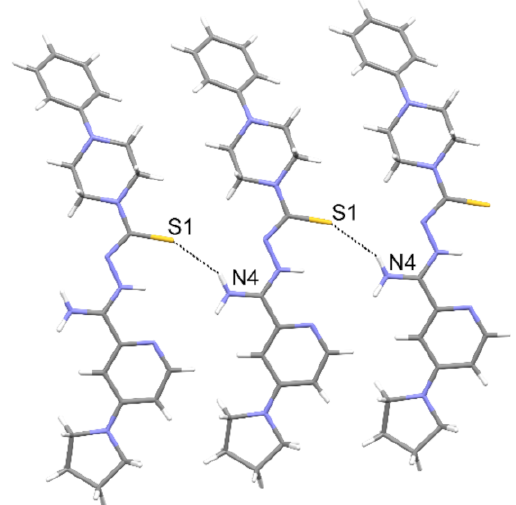
Figure 9. The intermolecular hydrogen bonds in compound 5